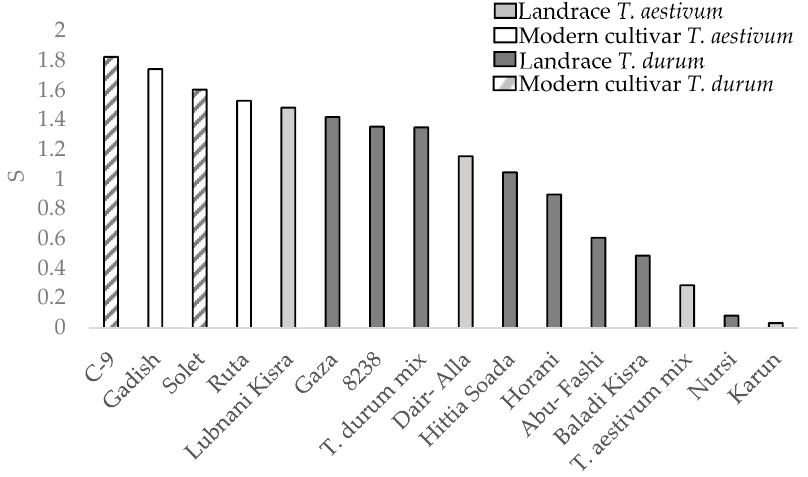
Figure 6. Drought susceptibility index (S) between wheat genotypes. Table 3. Mean of grain yield (GY), plant height (PH), lodging (Lg), growing degree days (GDDtH), relative drought yield (RDY), and drought susceptibility index (S) of modern cultivars and selected landraces during the 2018–2019 season. GY (t ha − 1 )